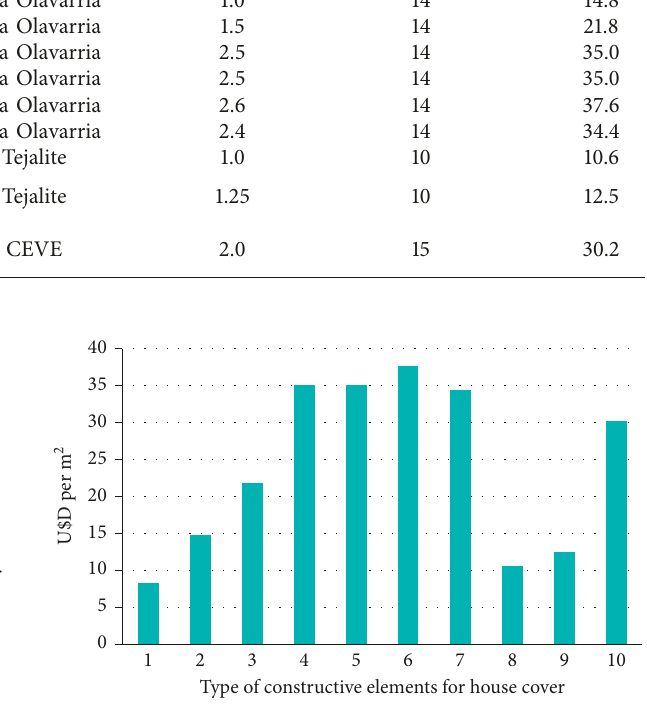
Figure 8: Comparative price chart of construction elements for house cover.